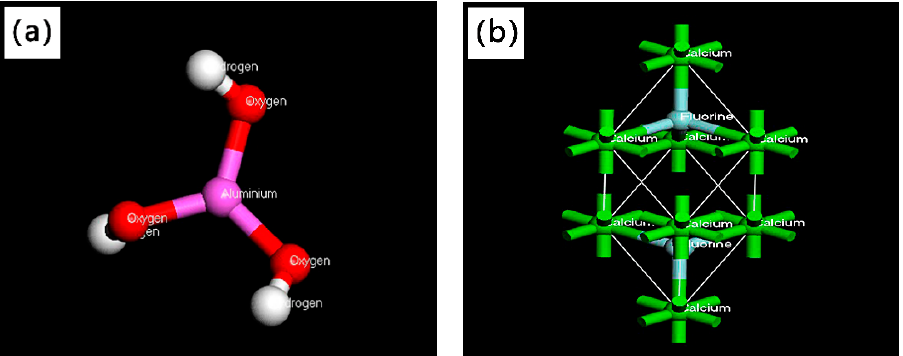
Figure 1. Model: ( a ) aluminum hydroxide (Al(OH) 3 ) molecular model; ( b ) calcium fluoride (CaF 2 ) unit cell model.